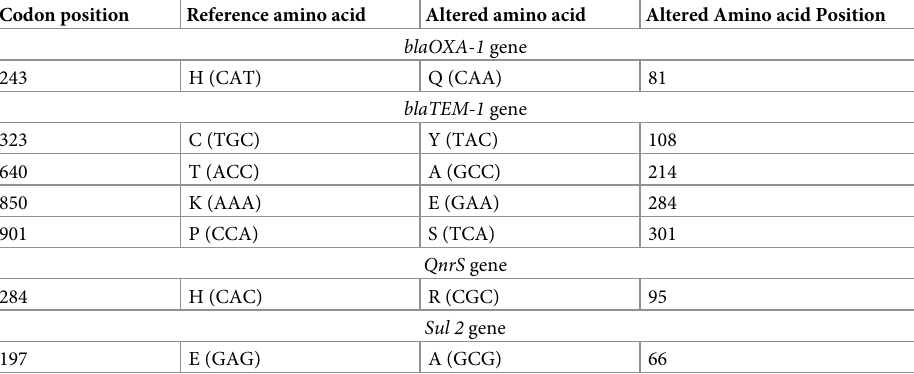
Table 7. Non-synonymous mutations.